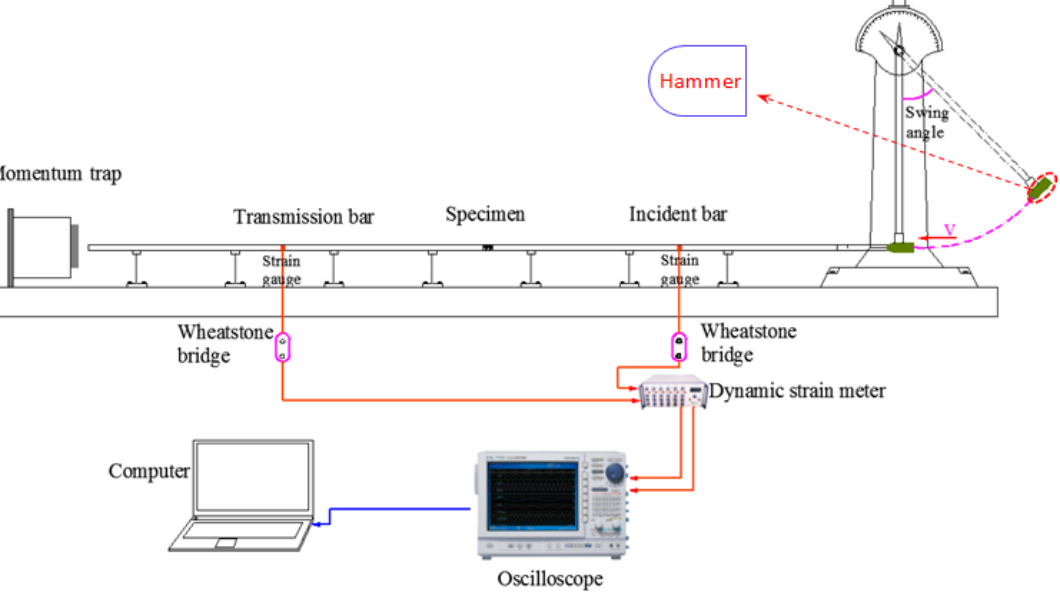
Figure 6. Diagram of the Split Hopkinson pressure bar (SHPB) apparatus [46].